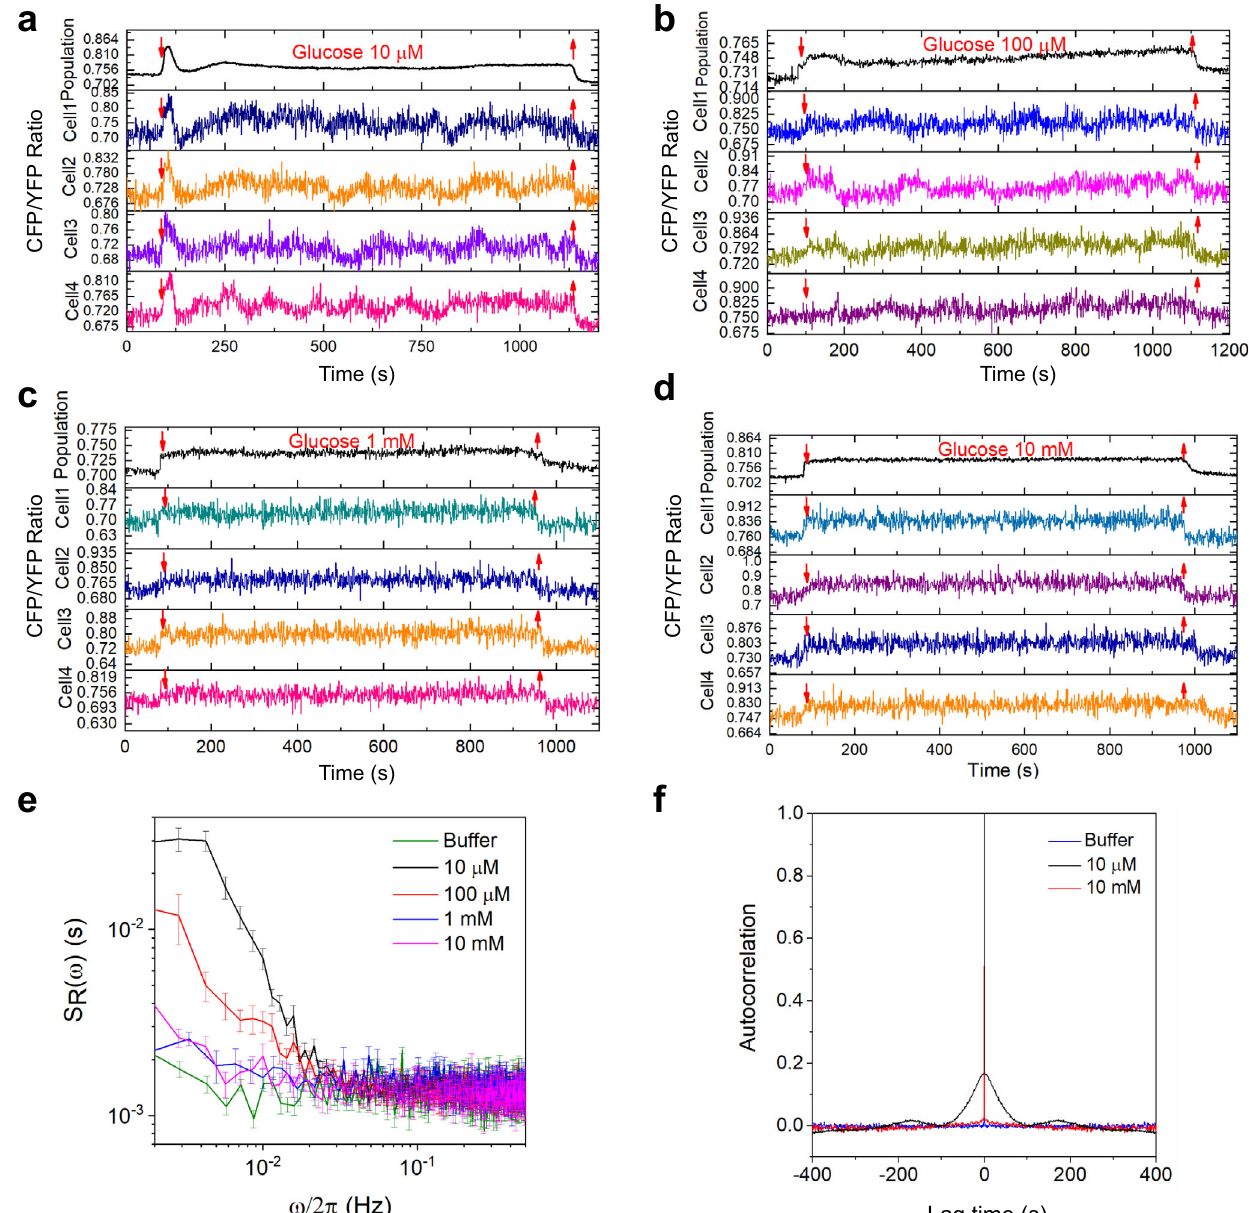
Fig. 3 | Dynamics of intracellular pyruvate levels in individual E. coli cells exposed to glucose. The population-averaged (black) and typical single-cell (col- ors) FRET measurements of pyruvate levels. Cells were fi rst equilibrated in M9 buffer and subsequently stimulated by addition and removal of 10 μ M ( a ), 100 μ M ( b ), 1mM ( c ), or 10mM glucose ( d ) at indicated time points. The average PSD ( e )